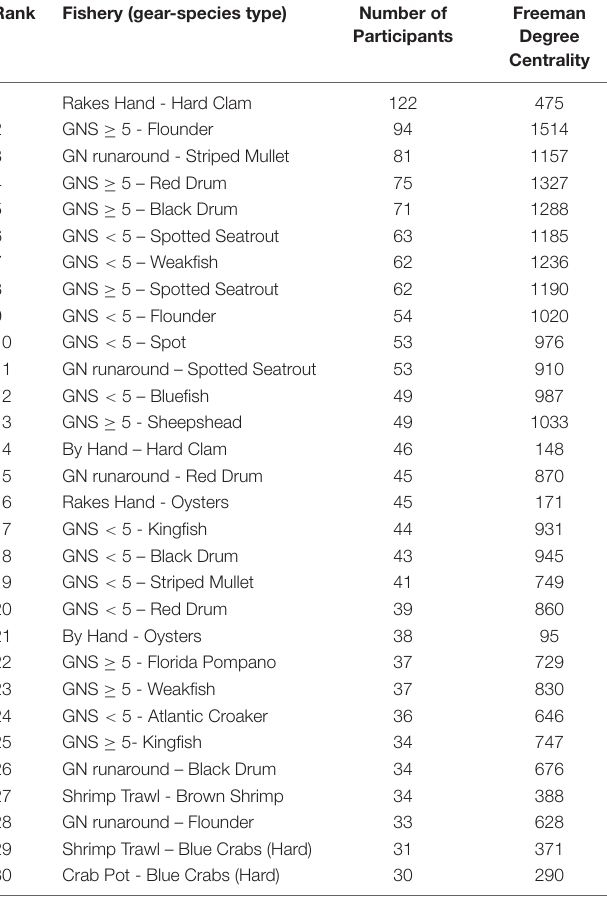
TABLE 2 | The number of participants in each of the gear-by-species fisheries of Core Sound (top 30 shown; complete listing in Supplementary Table SM-1